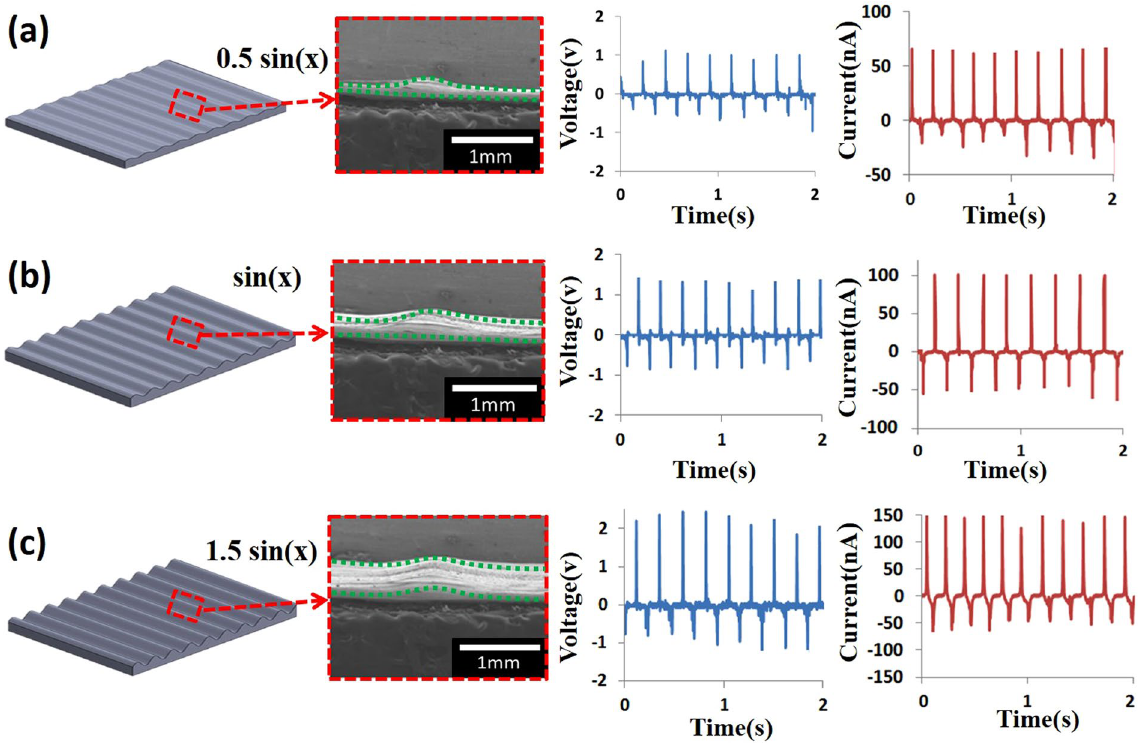
Figure 4. Effect of sinusoidal amplitude (Asin(x)) for wavy surfaces and corresponding output voltage and current. For the amplitude A is chosen as ( a ) 0.5 sin(x), ( b ) sin(x), ( c ) 1.5 sin(x). All dimensions are in